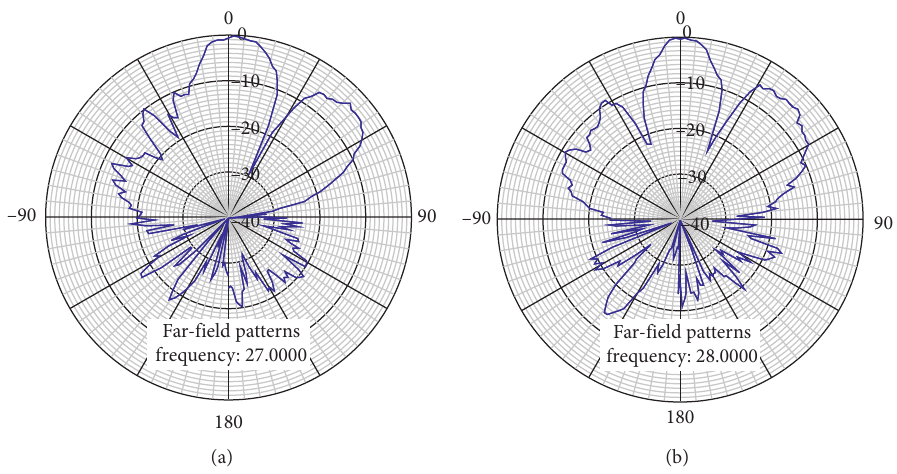
Figure 8: Copolarized radiation patterns in y - z plane at (a) f � 27 GHz and (b) f � 28